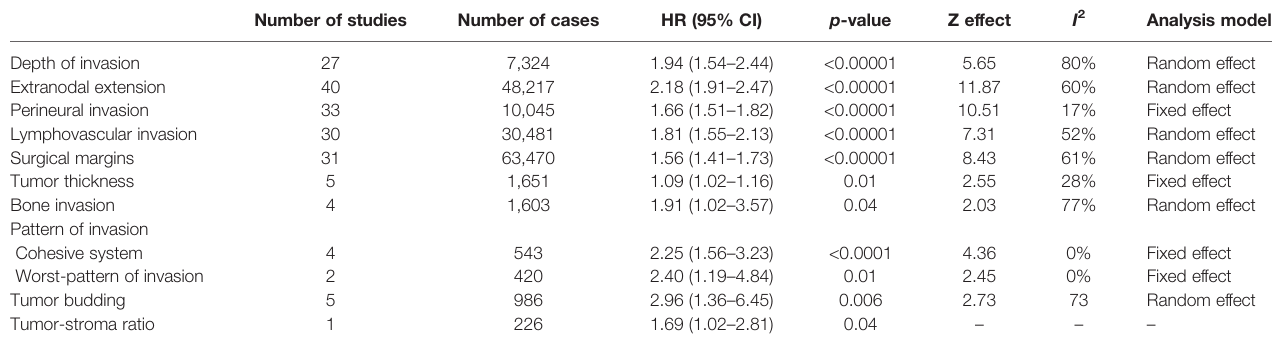
TABLE 1 | Effect of the selected histological features in the overall survival (OS) of patients with oral squamous cell carcinoma. Number of studies Number of cases